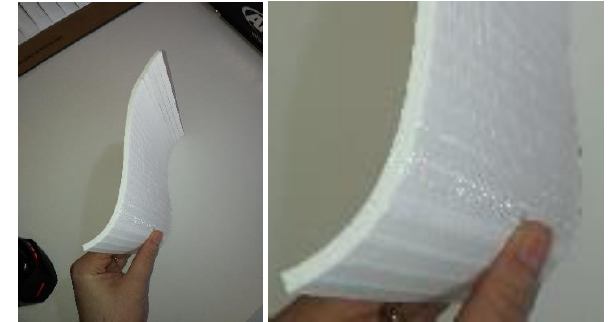
Figure 17: The interpretation of the bricklaying process using the